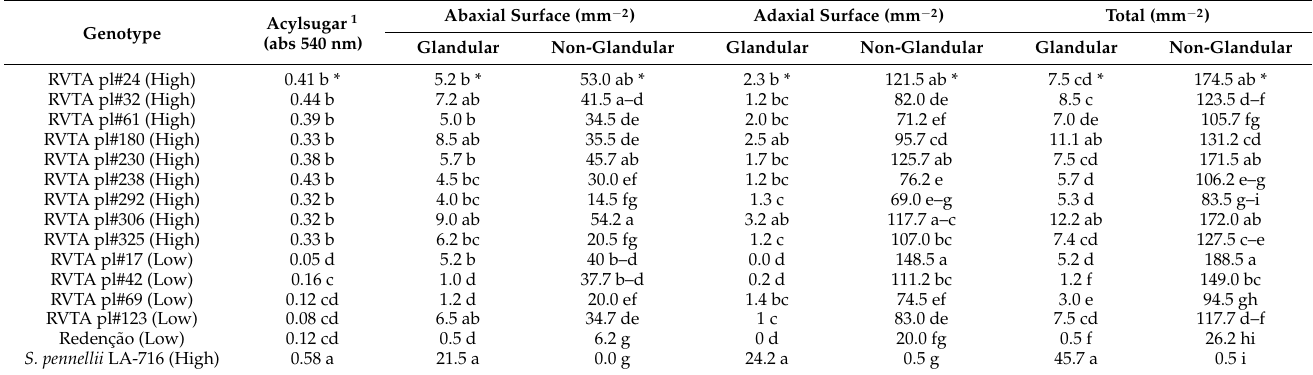
* Averages followed by the same letter do not differ by the Dunn–Bonferroni test ( p < 0.001); Kruskal–Wallis (H) 61.51. 1 Acylsugar contents at 540 nm (based on absorbance